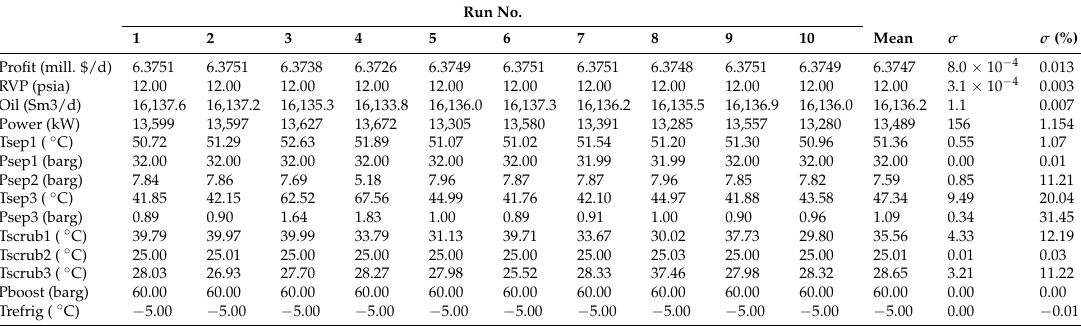
Table 4. Resultsfor main objective function, constraint function, supporting responses, and model variables from 10 consecutive runs using surrogate models in the NSGA-II algorithm. Run